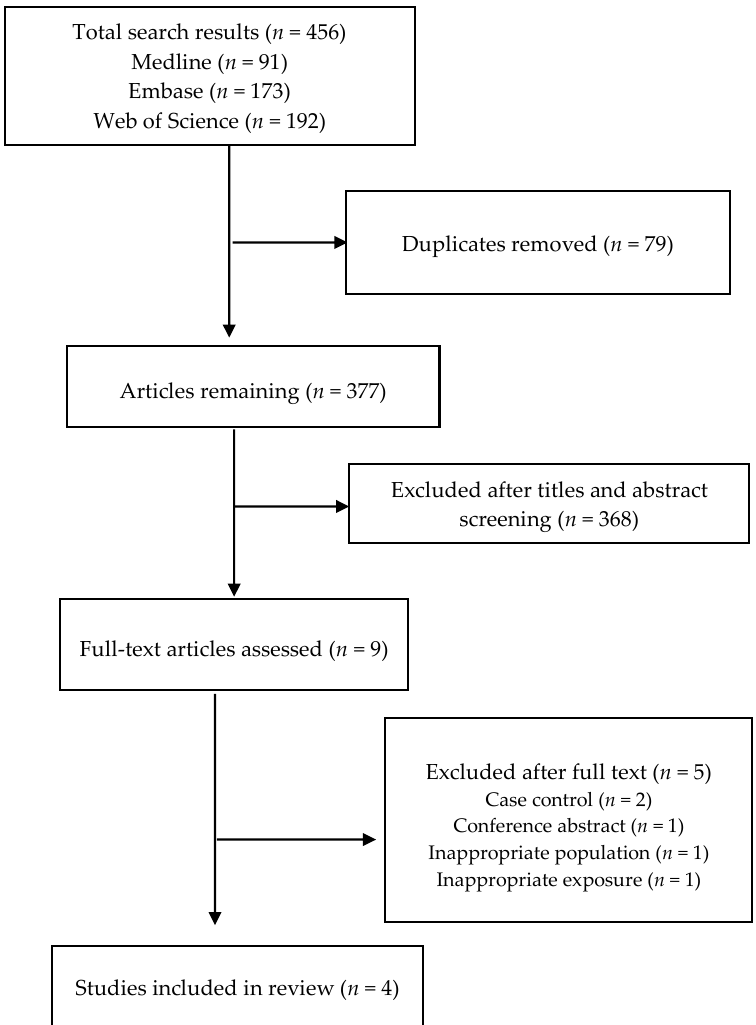
Figure 1. PRISMA flowchart of studies selection process.